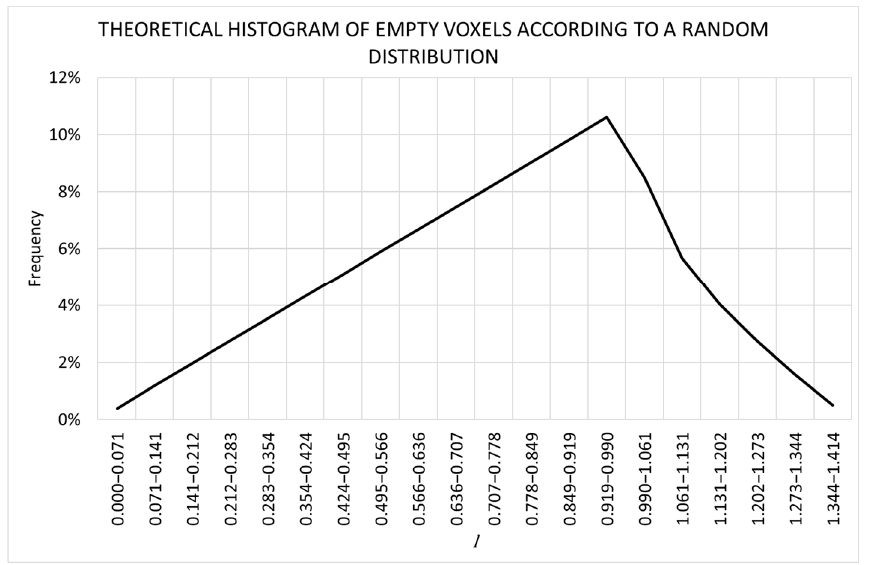
Figure 7. Circumferential test. Theoretical histogram of empty voxels according to a random distribution.